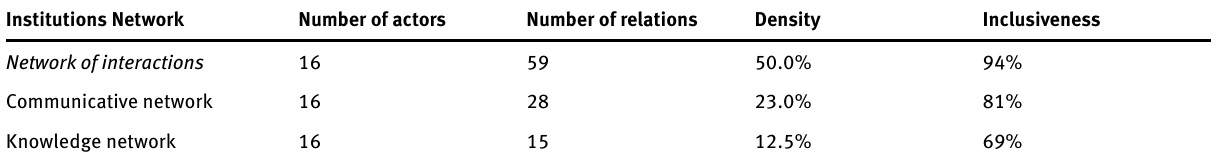
Table 2: Institutions network indexes Institutions Network